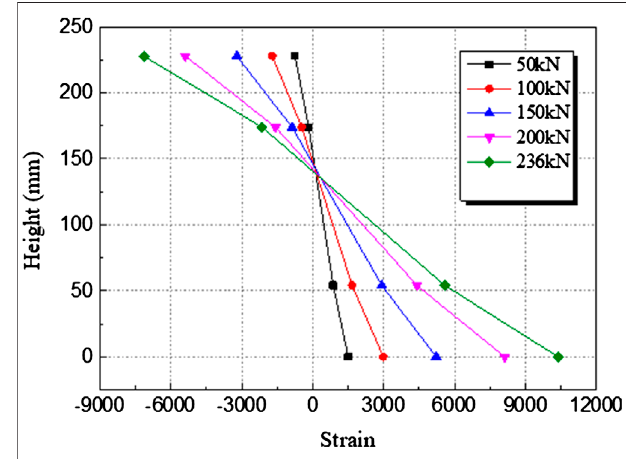
FIGURE 13 | Effect of tensile steel bars on the tensile behavior of the bottom fl ange.